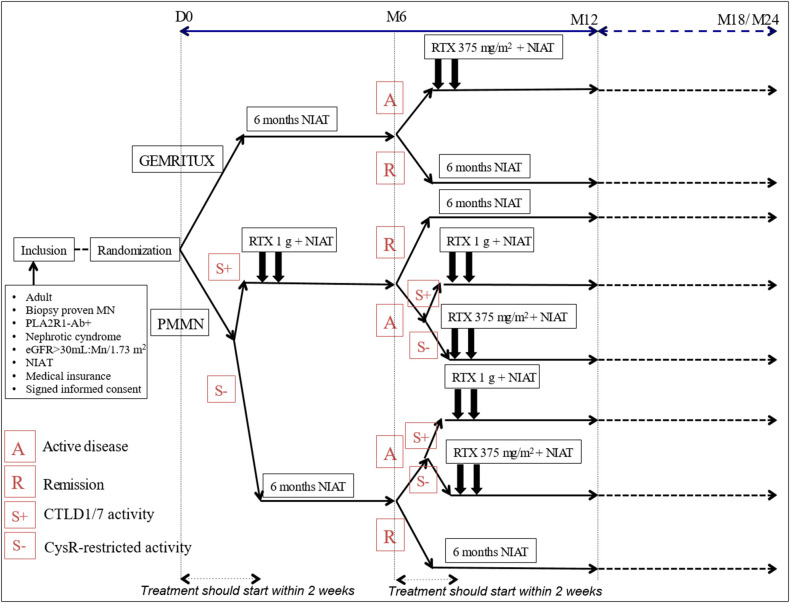
Detailed overview of the PMMN study protocol. A, active disease; eGFR, estimate glomerular filtration rate; MN, membranous nephropathy; NIAT, Non immunosuppressive antiproteinuric treatment; PLA2R1-Ab, antibodies for phospholipase A2 receptor: R, remission; RTX, rituximab; S-, CysR-restricted activity; S+, CTLD1/7 activity.